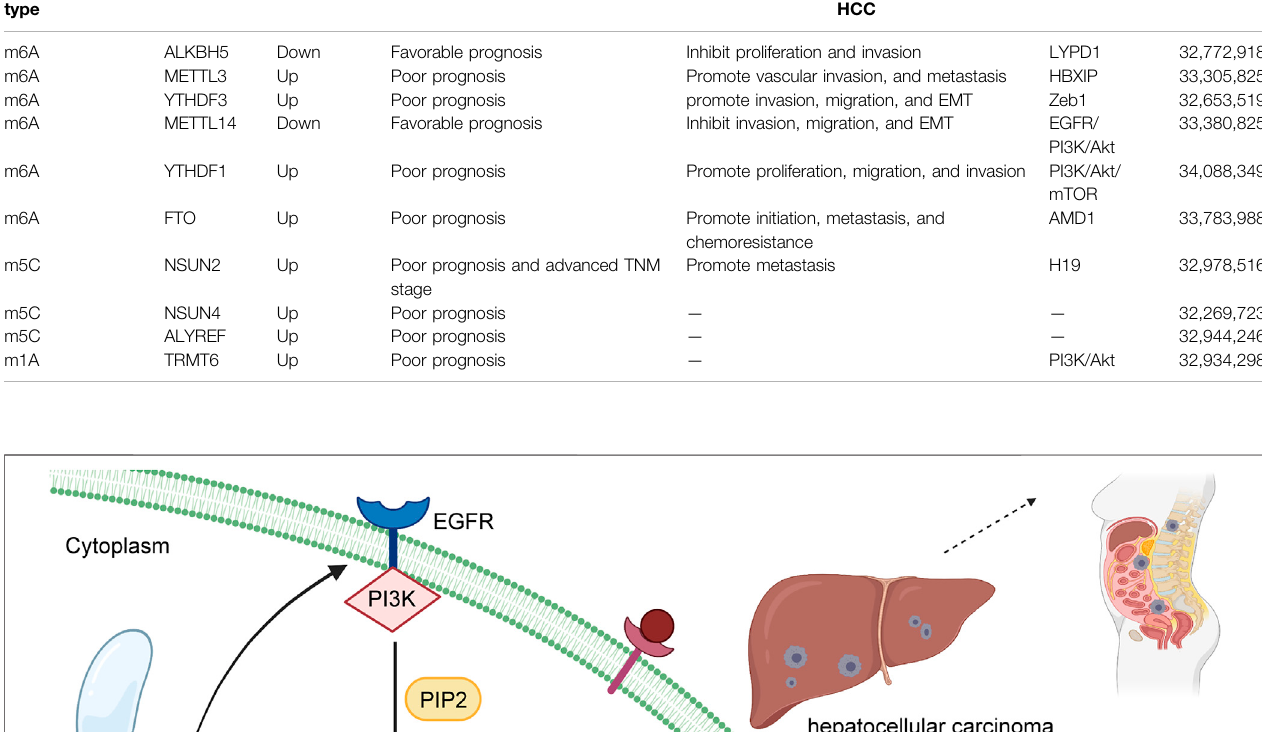
Frontiers in Cell and Developmental Biology |